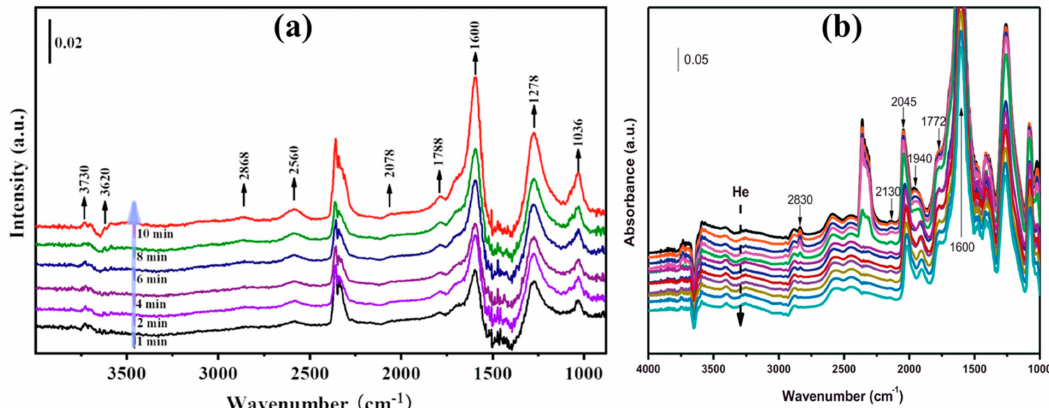
Figure 5. Operating DRIFT spectra captured after injecting a CO 2 /H 2 mixture: ( a ) LN − CeO 2 , reprinted with permission from [86]. Copyright Elsevier, 2022, ( b ) Pt − Ce catalyst calcined at 500 ◦ C, reprinted with permission from [94]. Copyright Elsevier, 2016.